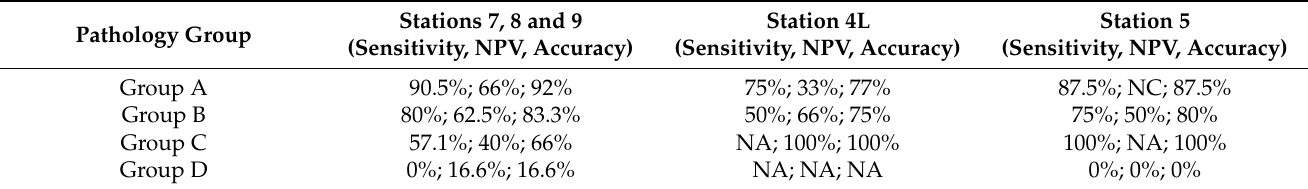
Table 3. Sensitivity, NPV and diagnostic accuracy of lymph node stations by pathology